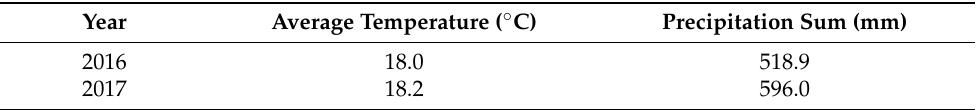
Table 1. Average temperature ( ◦ C) and precipitation sum (mm) during the growing season,